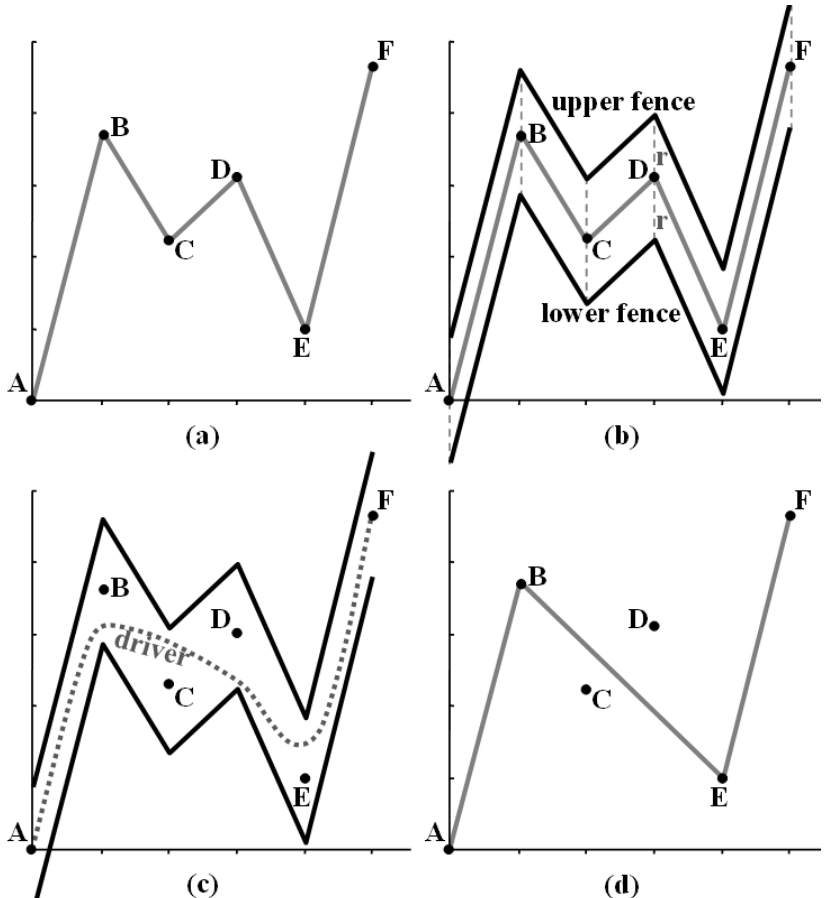
Figure 1: Uniaxial racetrack filter example, showing: (a) the original history; (b) the racetrack defined between the upper and lower fences; (c) the driver path from A to F; and (d) the filtered